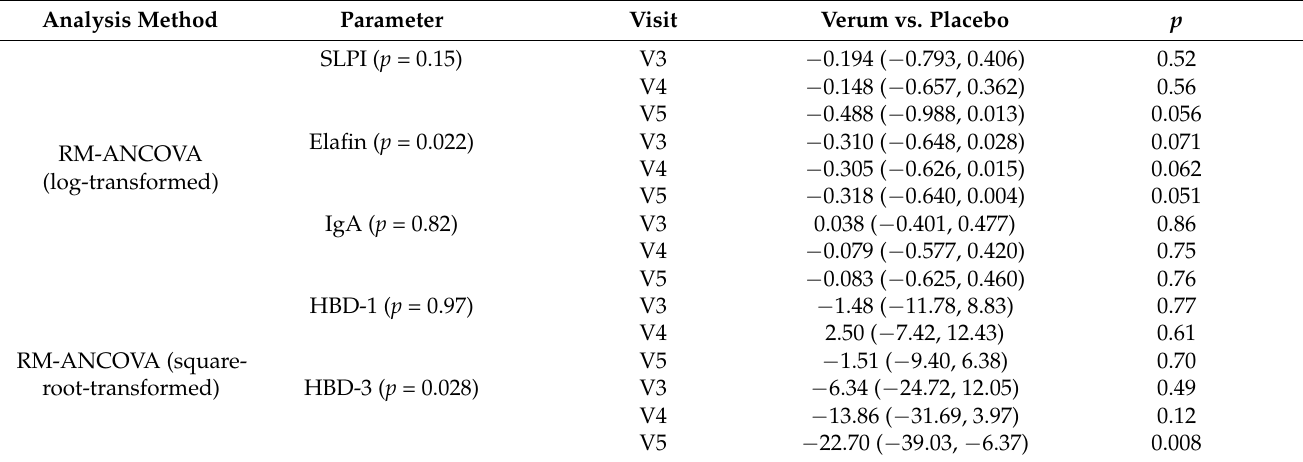
Table 10. The effect of the supplementation on vaginal immune markers during the intervention (V3 and V4) and follow-up (V5). HBD, Human β -defensin; IgA, Immunoglobulin A; SLPI, Secretory leukocyte protease inhibitor; V, Visit; V3, after one week of intervention; V4, after two weeks of intervention; V5, after a one-week